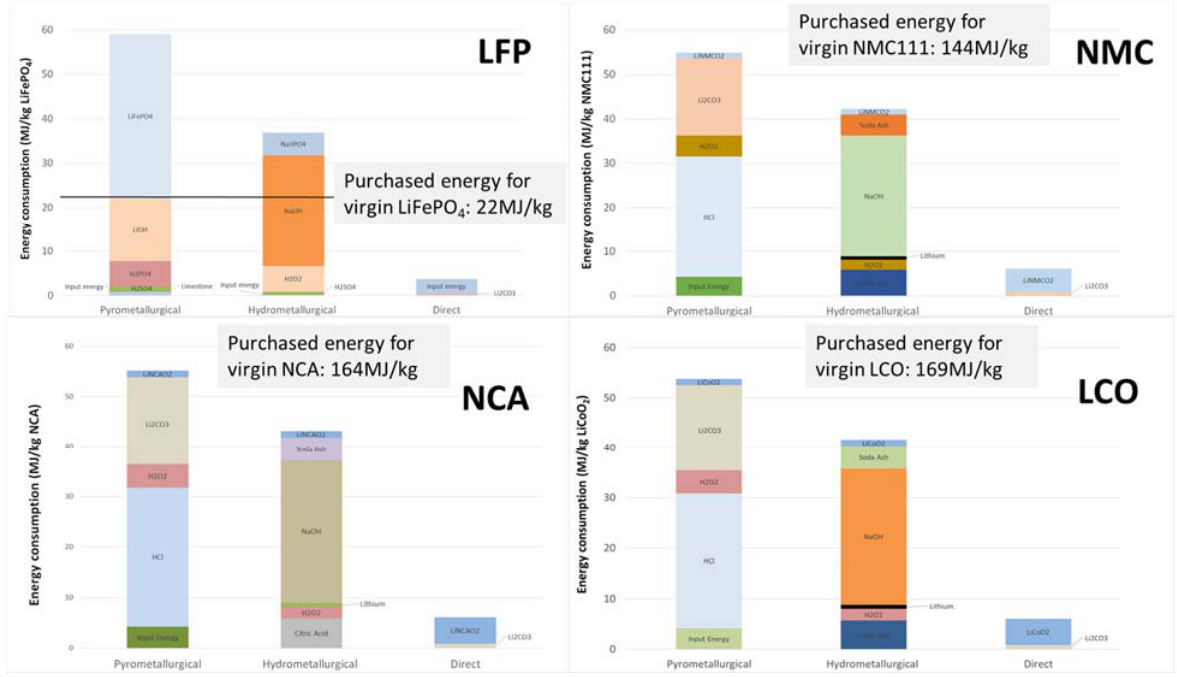
Figure 3. The energy consumption comparison between pyro, hydro, and direct recycling technologies for different cathode chemistry.